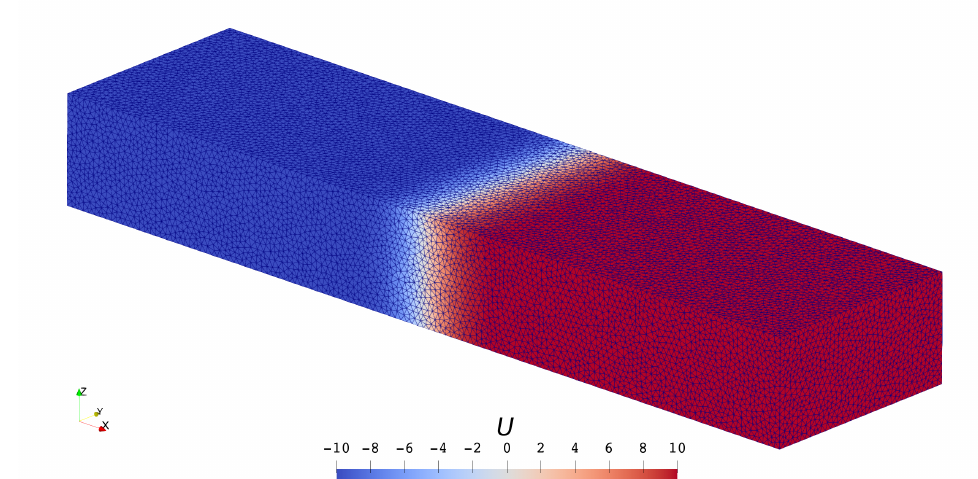
Figure 3. First-order solution of Problem 1 on tiny ( h ≈ 2 − 5 ) cells.